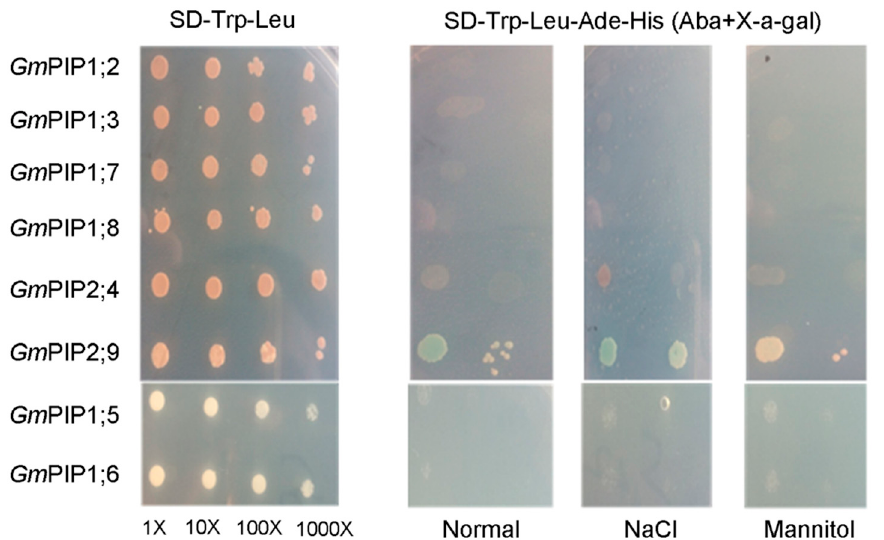
Figure 4. Y2H to test homotetramerization of Gm PIPs. Six GmPIP1 and two GmPIP2 genes were selected to construct the pGADT7 and pGBKT7 vectors. The same genes expressed in AD and BD were co-transformed into the Y187 and Y2H gold yeast strain. The fresh yeast cells (OD 600 = 1.0) were spotted in 1-, 10-, 100- and 1000-fold dilution media on the SD-Leu-Trp plates or on SD-Leu-Trp-